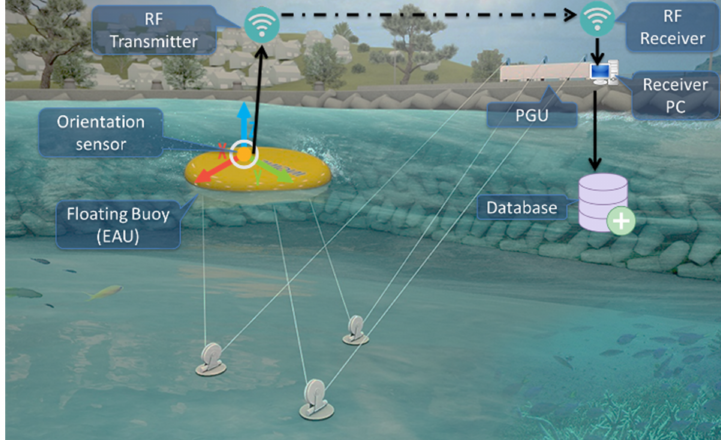
Figure 3. Schematic diagram of the data collection procedure.